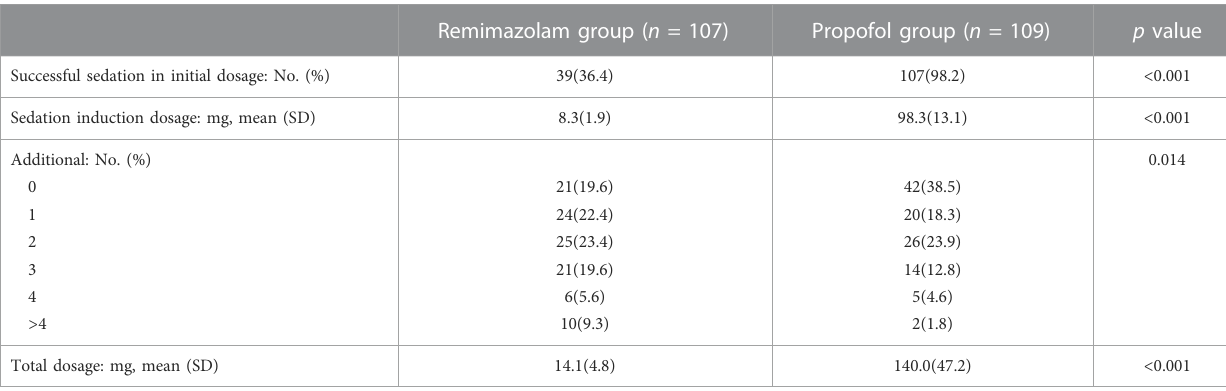
TABLE 3 Comparison of sedative drug dosages.